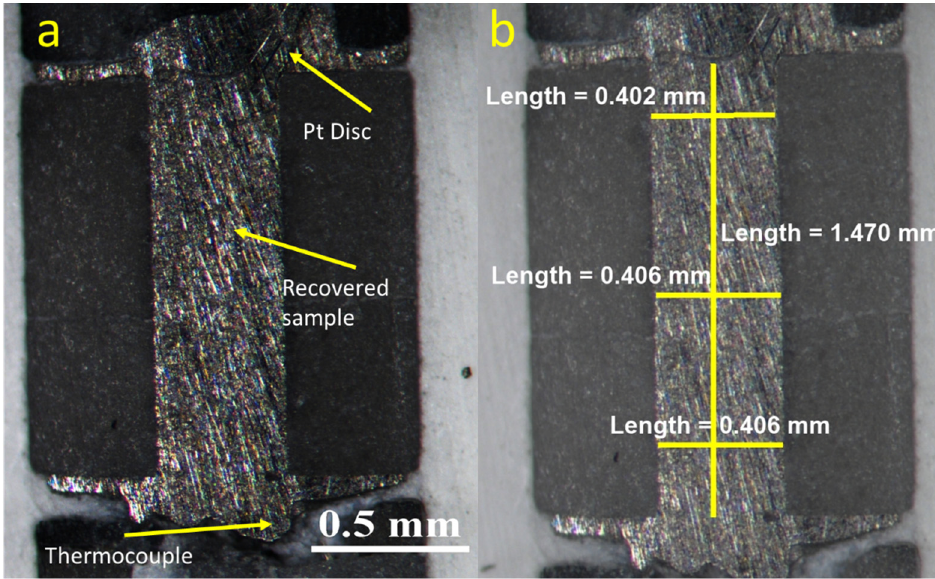
Figure 2. Cross sectional image of Fe-5 wt% Ni recovered from 4 GPa and 1986 K ( a ) Cross sectional image of a polishing stage of the sample ( b ) Cross sectional image of a polishing stage of the sample with the value for the length and diameter recorded)